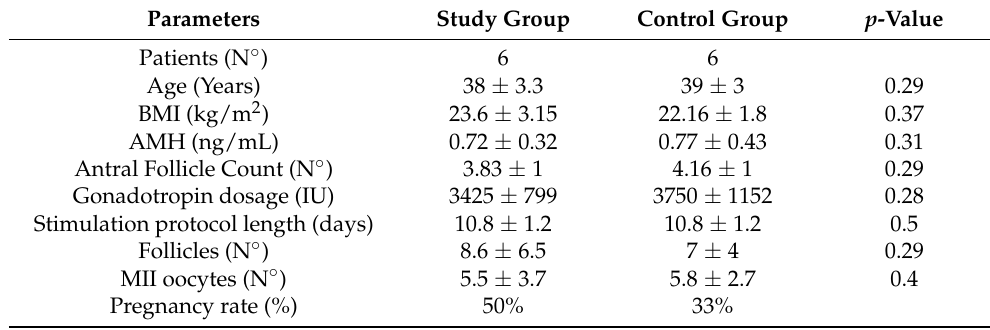
Table 1. Clinical parameters of women enrolled in the study. Values are reported as mean ± standard deviation or percentage (%). p -values are based on a two-sample t -test. MBI: body mass index; AMH: anti-Müllerian